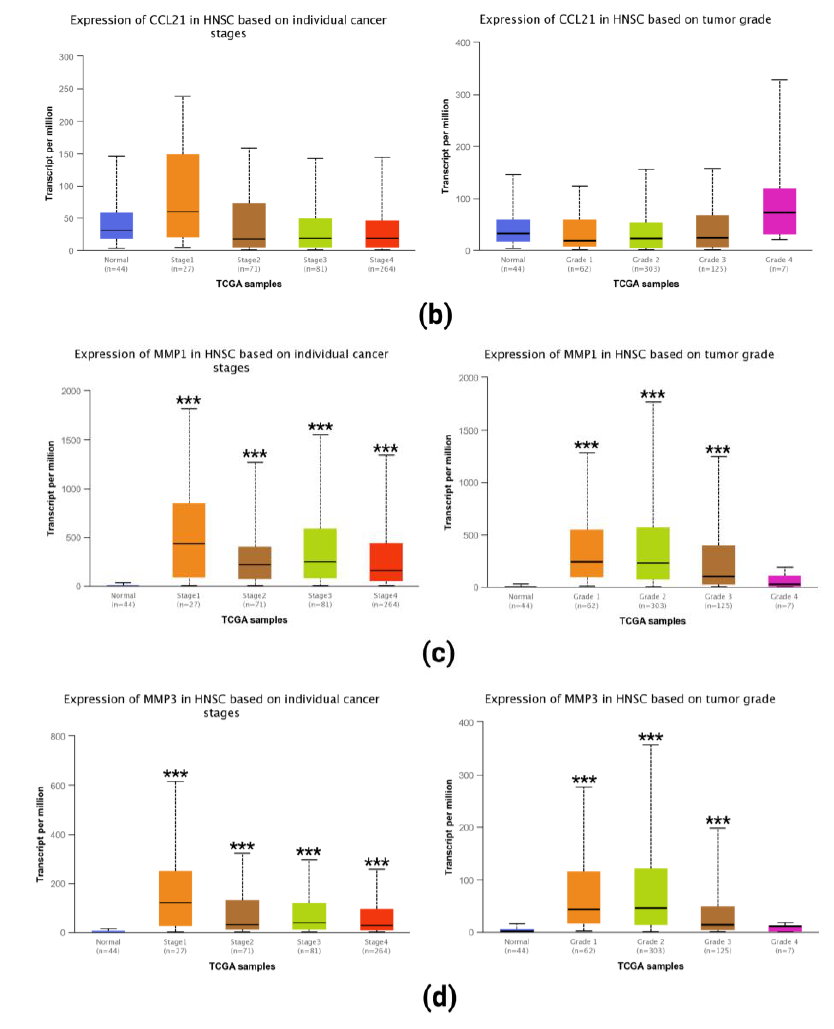
Figure 9. Different expressions of PTGS2 ( a ), CCL21 ( b ), MMP1 ( c ), and MMP3 ( d ) between normal and tumor tissues, ***: p < 0.001.